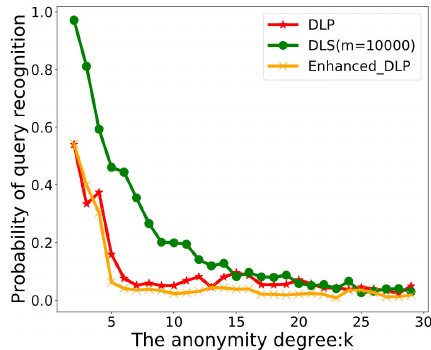
Figure 5. Scenario 2: The probability of query recognition versus k